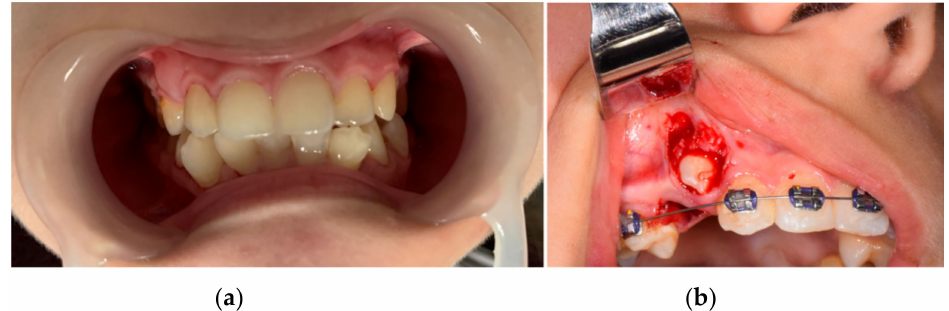
Figure 2. Intraoral photos in occlusion ( a ) and from the surgical intervention ( b ).